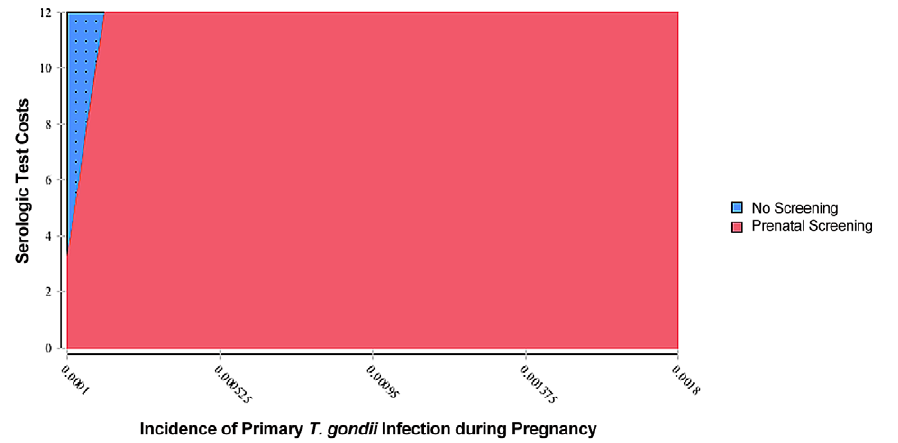
Figure 9. Two-way sensitivity analysis on incidence of primary T.gondii infection during pregnancy and serologic test costs.